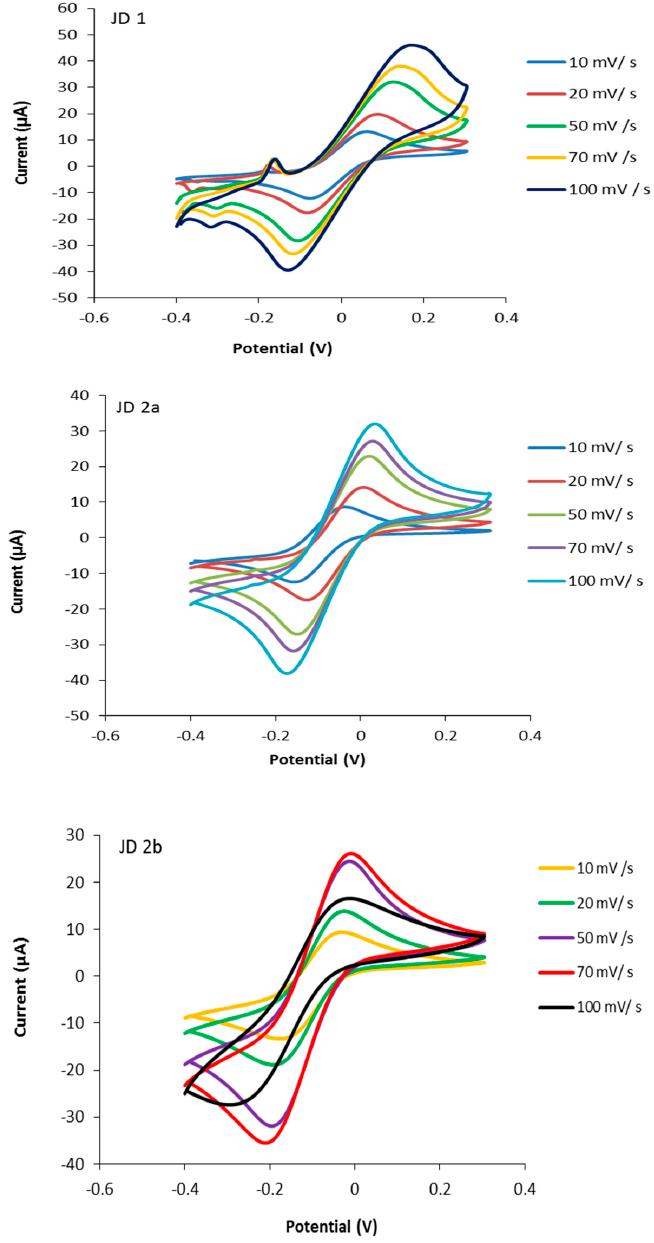
Figure 1. Cyclic voltammogram of the different electrodes at different scan rates using a 1 mM potassium ferricyanide solution in 0.1 M KCl, n = 3.